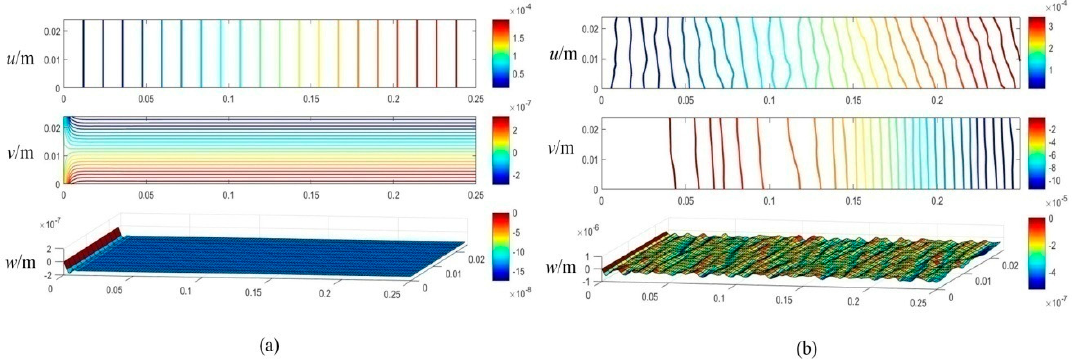
Figure 6. Structural response to tensile load ( a ) without wrinkles and ( b ) with randomly distributed wrinkles.